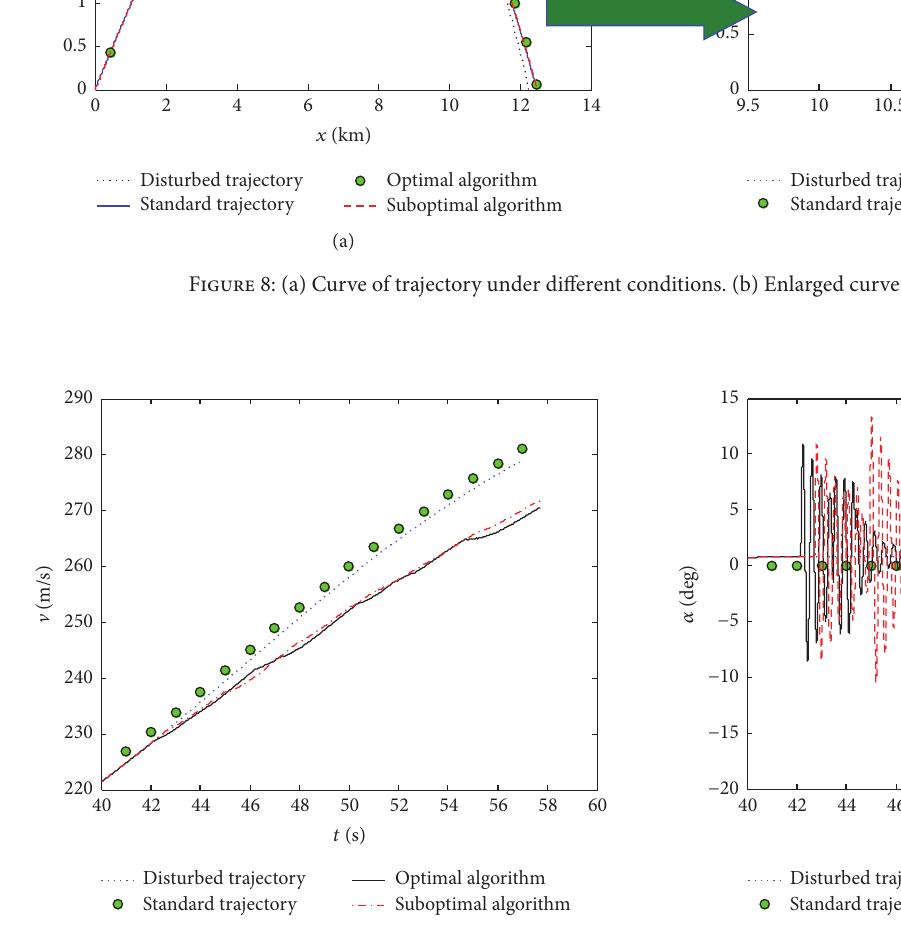
Figure 9: History between V and 𝑡 . Figure 10: History between 𝛼 and 𝑡